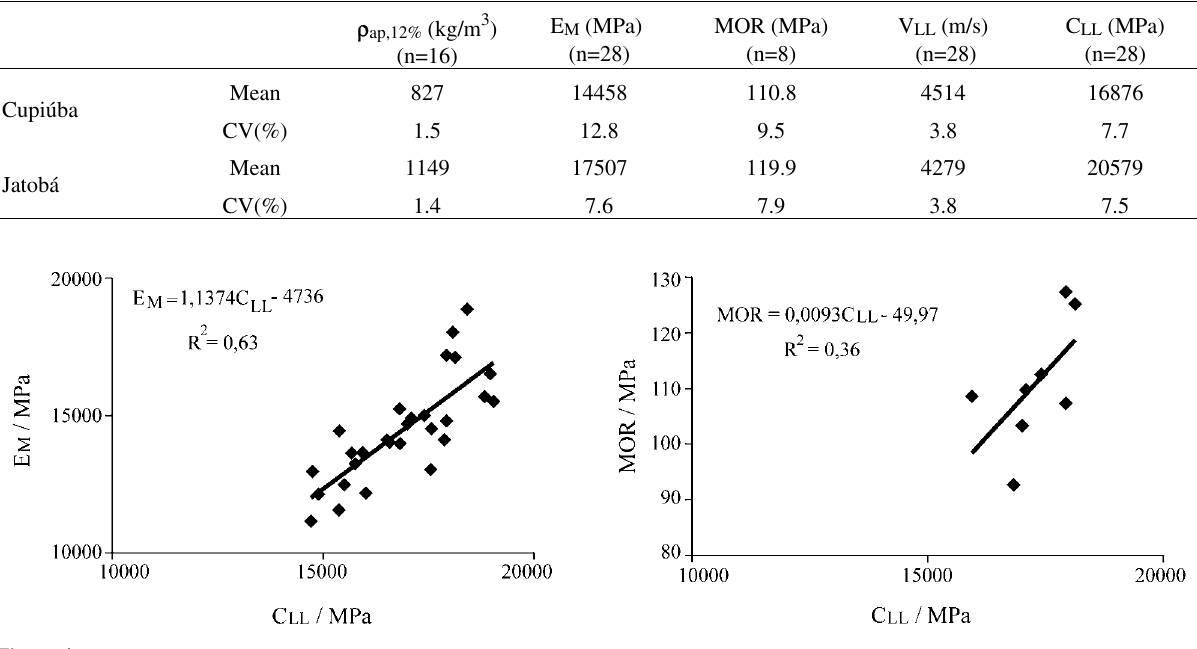
Figure 4. E M and MOR as a function of CLL for the “cupiúba” species.